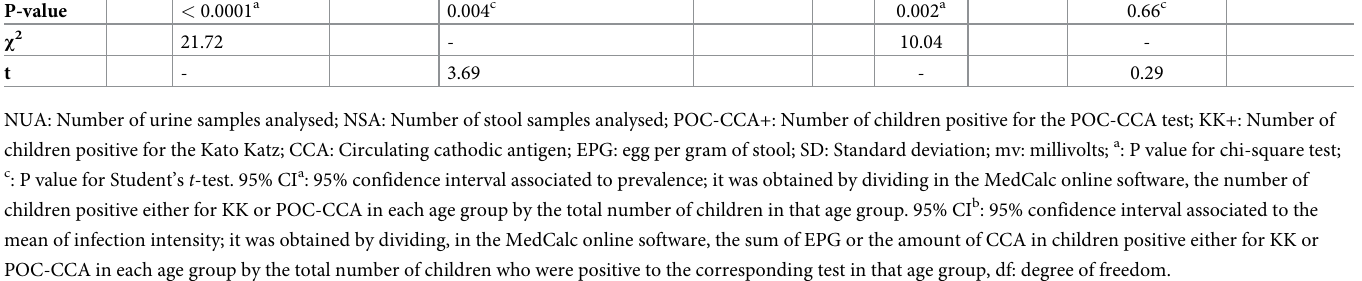
(Table 2). The values of the prevalence were significantly ( χ 2 = 5.57, p = 0 . 018 , df = 1 ) different